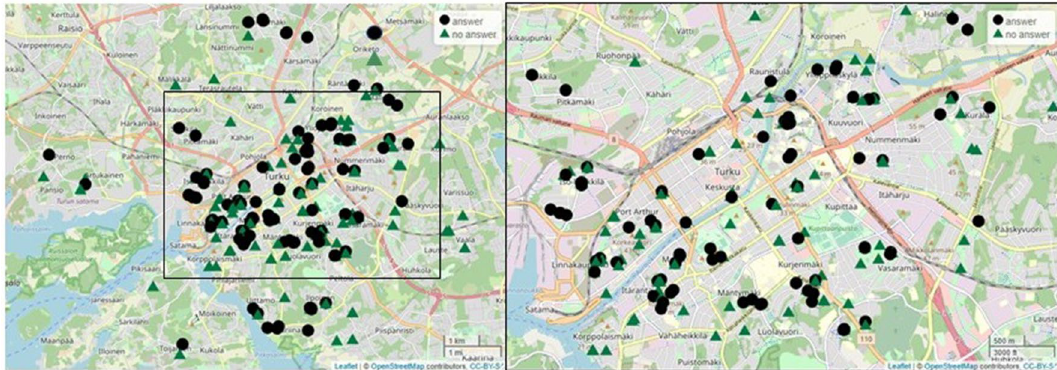
Figure 5. Map of Turku city area presenting the locations of the urban box gardening groups. The boxes were distributed around Turku quite evenly (on the left all the locations), however concentrating on the city center (augmented map on the right). The black circles represent groups, who answered the questionnaire and the green triangles the groups, who didn`t answer the